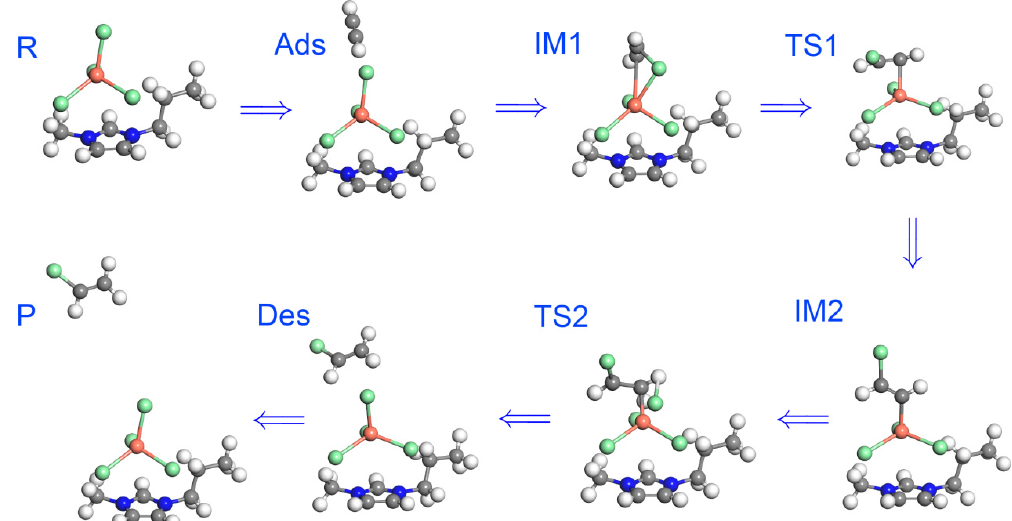
Figure 16. Reaction path of acetylene hydrochlorination near the Cu(II) atom, as catalyzed jointly by the catalyst CuCl 2 and the reaction media [PrMIm]Cl. Shown is the process in which the anion [CuCl 4 ] 2 − participates in the catalysis. Here Cu exists in the form of [CuCl 4 ] 2 − , and is adsorbed near the N atoms of [PrMIm]Cl. The color coding is the same as Figure 15.